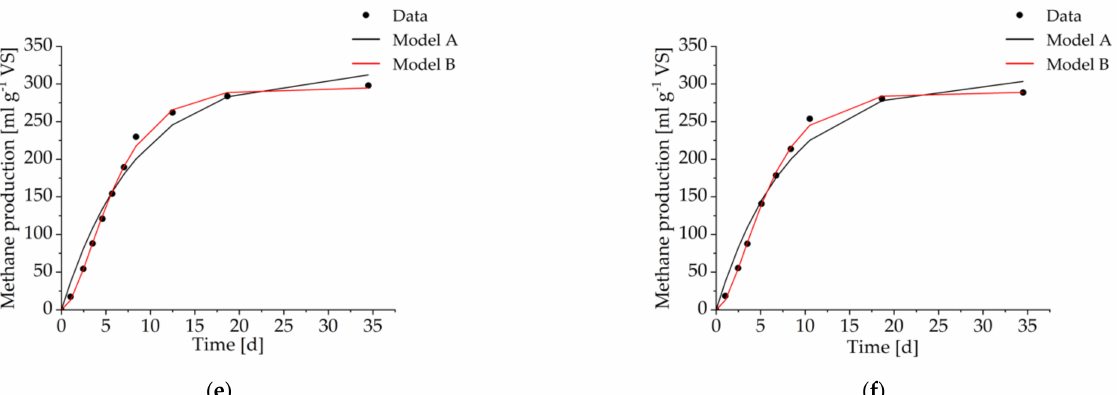
Figure 2. First order model fits illustrated by experimental data (black points) and predicted values by the first-order model (black line) and the first-order two-step model (red line) for untreated wheat straw ( a ) and hydrothermally pretreated wheat straw samples ( b ) HTP-160-15; ( c ) HTP-160-45; ( d ) HTP-170-30; ( e ) HTP-180-15; ( f ) HTP-180-45.